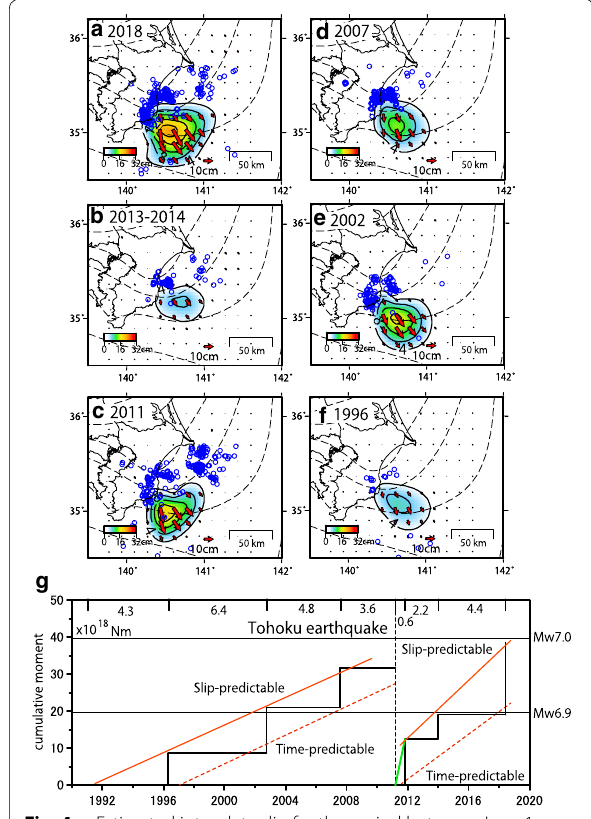
Fig. 4 a Estimated interplate slip for the period between June 1, 2018 and July 23, 2018. The contour interval is 4 cm. Blue circles indicate the hypocenters of earthquakes within 5 km from the plate interface for the corresponding period. The nomenclature is the same as that in Fig. 3. b December 23, 2013–January 30, 2014. c October 12, 2011–December 10, 2011. d August 3, 2007–September 7, 2007. e September 23, 2002–November 30, 2002. f May 7, 1996–June 24, 1996. g Cumulative moment and recovery of the recurrence interval. The red solid line shows the slip-predictable model line while the red broken line shows the time-predictable model line before and after the Tohoku earthquake (see text). The green line is the slip-predictable line between March 2011 and October 2011, whose slope appears to be high compared with that after the October 2011 event (see